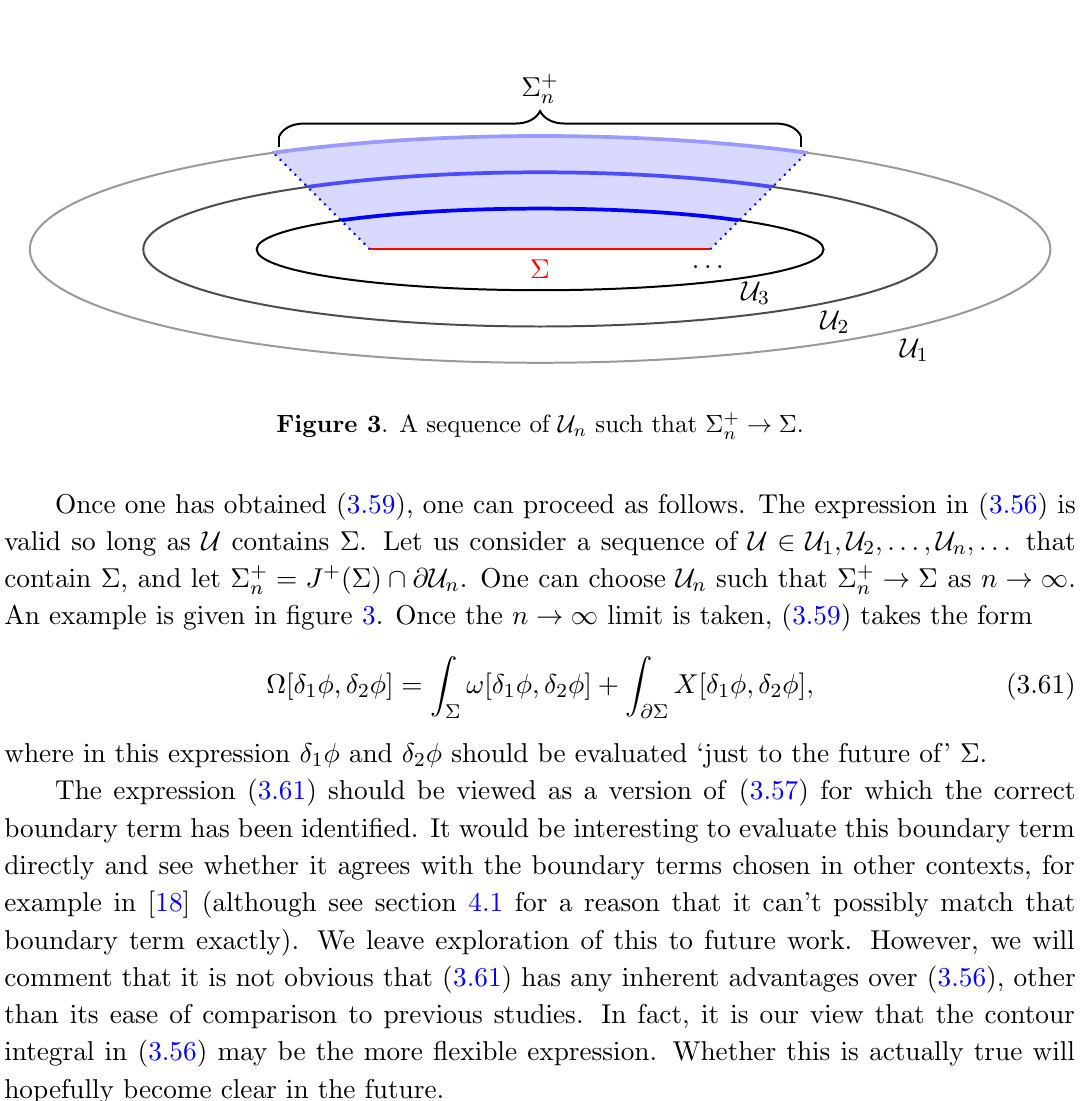
Figure 3 . A sequence of U n such that (cid:6) +